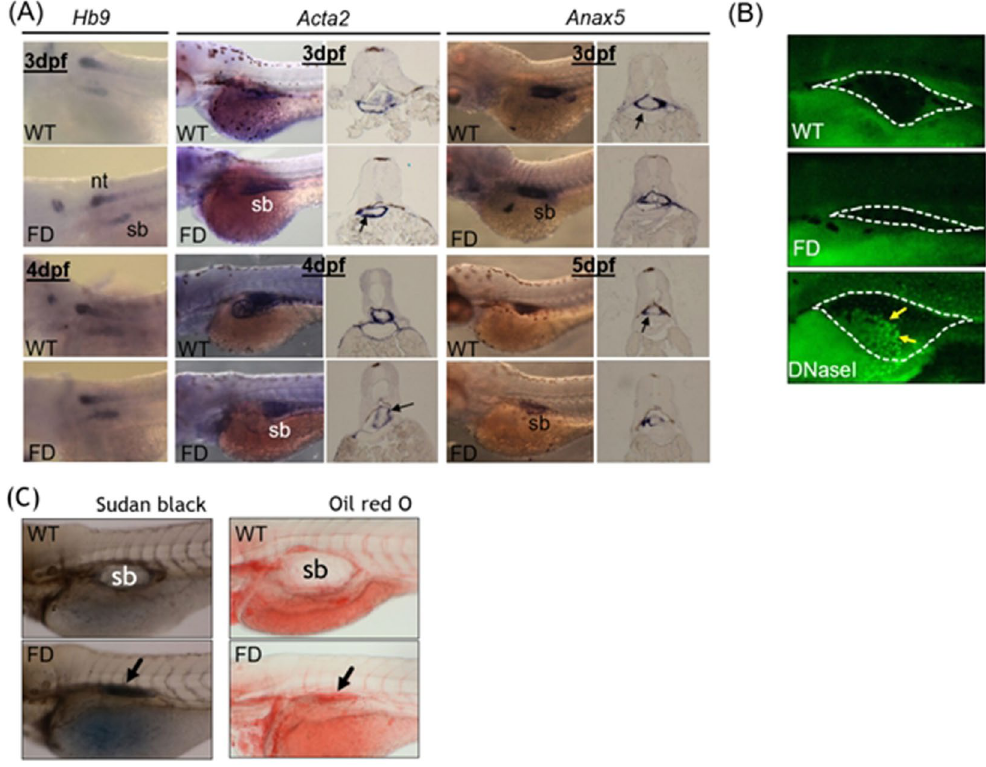
Figure 2. The tissue integrity and pathology of the swim bladder in wild-type and FD embryos and larvae. Heat-shocked larvae of both wild-type control and Tg( hsp :EGFP-GGH) were harvested at indicated stages post embryogenesis and analyzed for swim bladder development. ( A ) Embryos were subjected to WISH with tissues specific probes including Hb9 (epithelial layer), Acta2 (mesenchyme layer, smooth muscle) and Anax5 (outer mesothelium layer). Cross-sections of the embryos after WISH staining revealed comparable intensity and morphology for the tissue layers composed of swim bladders (black arrows) in the early embryos. ( B ) Larvae at 5 dpf examined with TUNEL assay for apoptotic cells (arrows) revealed no positive signal in the swim bladder area (circled by dash-line) of both wild-type control and FD larvae. Embryos pre-treated with DNase I served as a positive control. ( C ) Larvae at 5 dpf were stained with Sudan black (left) and Oil red O (right) to reveal outlines of swim bladder (black arrows) in larvae. nt, neural tube; sb, swim bladder; WT, wild-type larvae with heat-shock; FD, FD larvae with heat-shock.